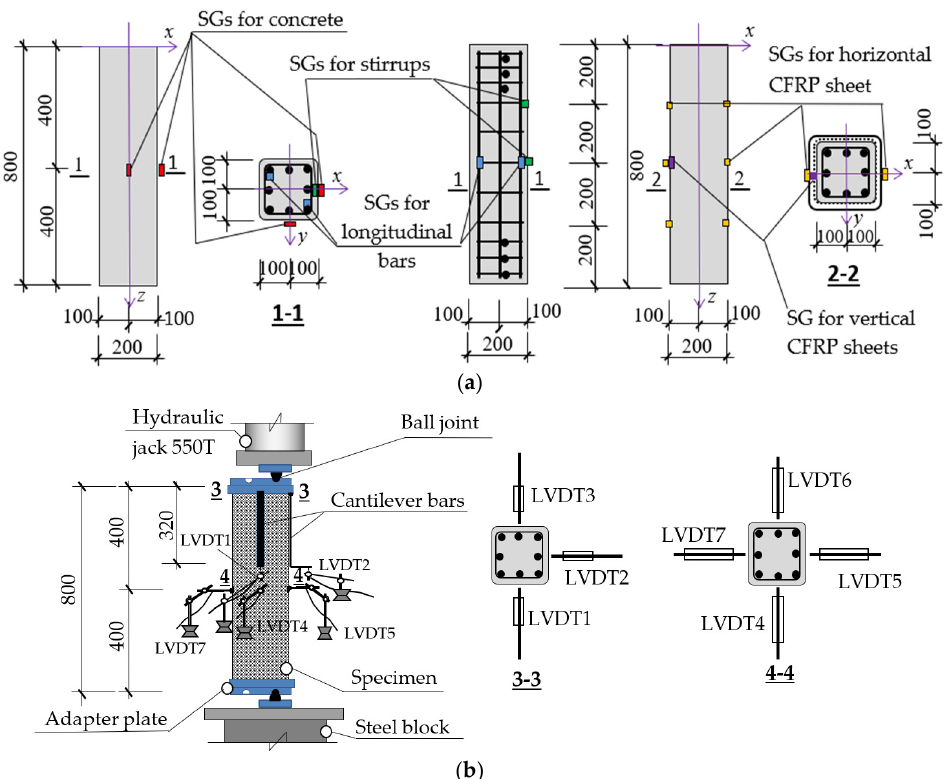
Figure 7. Location of strain gauges and LVDTs (in mm): ( a ) Strain gauges; ( b ) LVDTs.